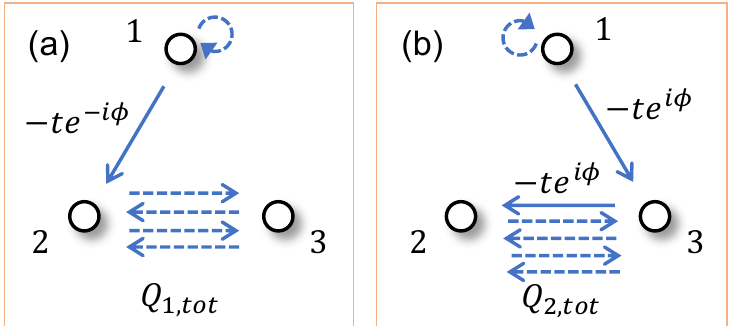
Figure 4: Schematic showing more complicated trajectories that contribute to the overall propagation from cavity 1 to cavity 2 (with t denoting the hopping amplitude J ). We can organize all of these into two categories, with respective amplitudes Q and Q (see 2, tot